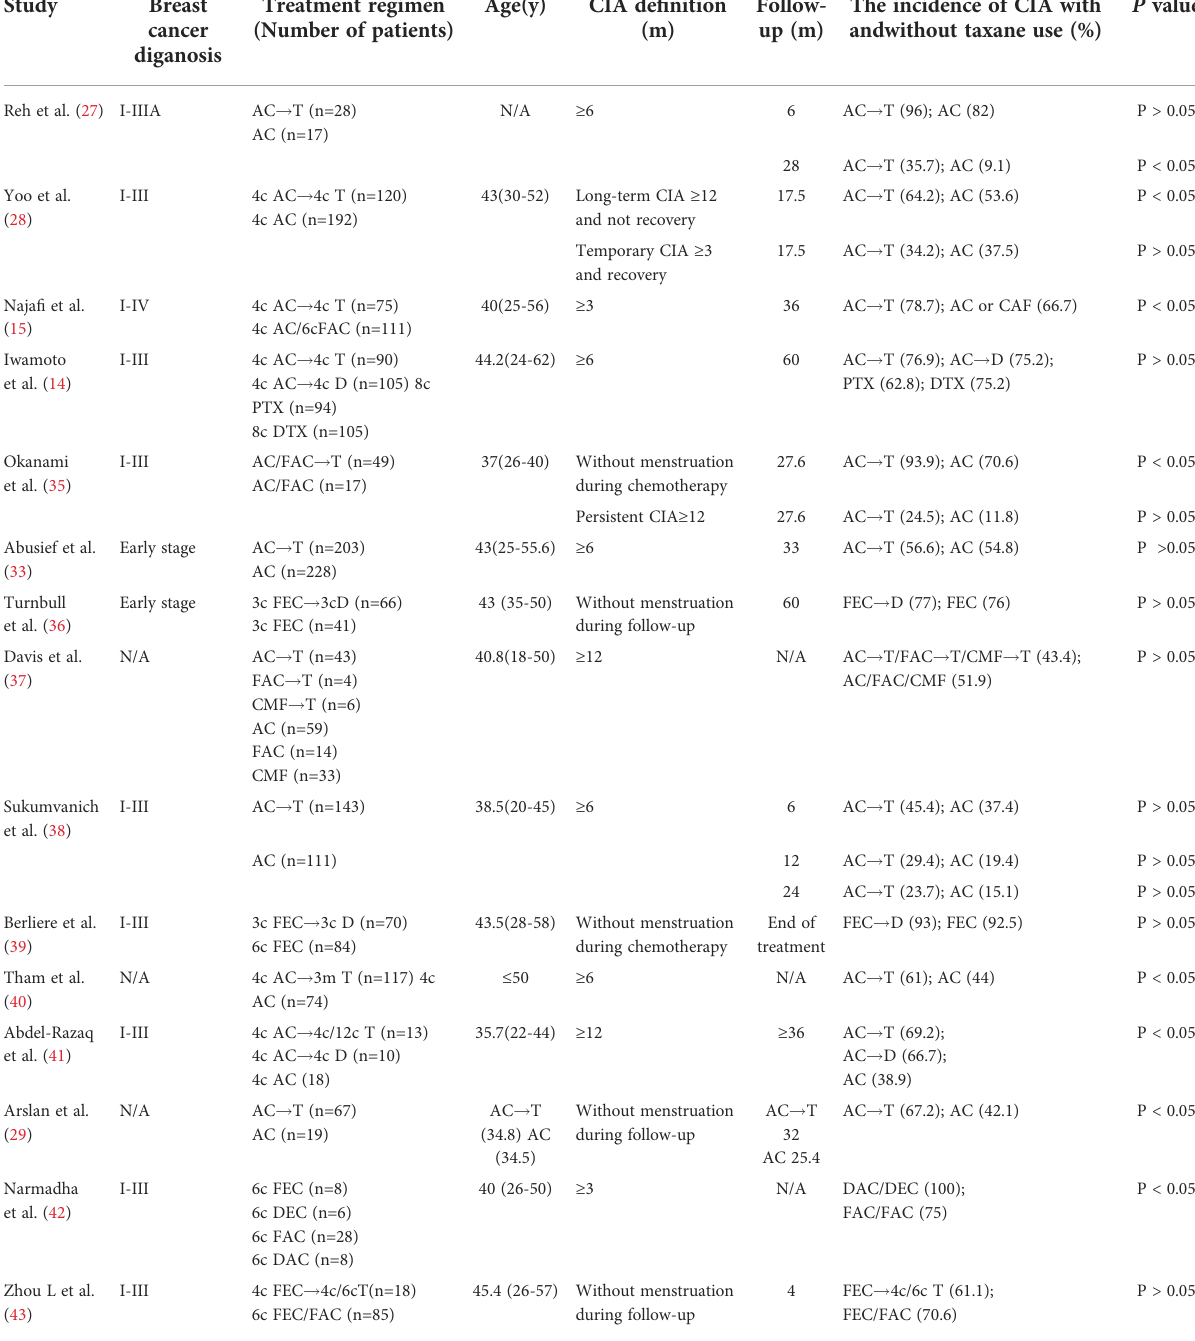
TABLE 2 The incidence of CIA with taxane-based